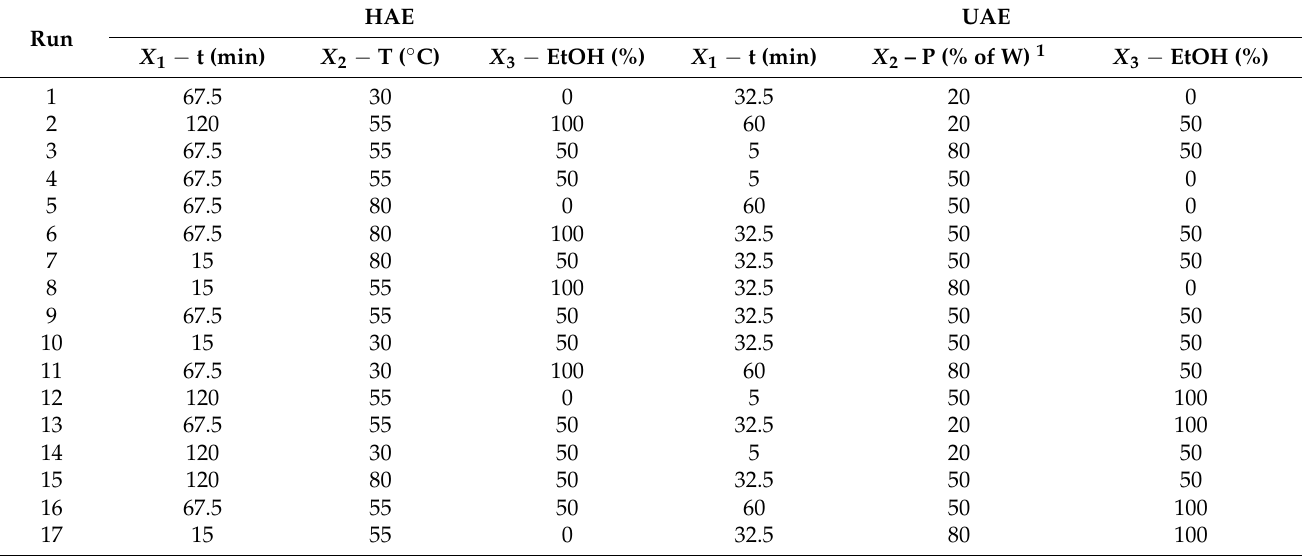
Table 1. Time, temperature (for the heat-assisted extraction; HAE) or power (for the ultrasound- assisted extraction; UAE), and percentage of ethanol (EtOH) in the solvent, obtained from Box– Behnken experimental design for the extraction